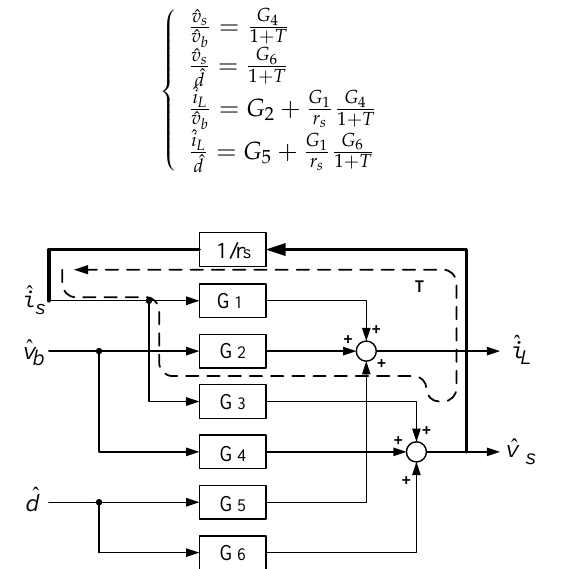
Figure 8. Small-signal block diagram with added PV module.